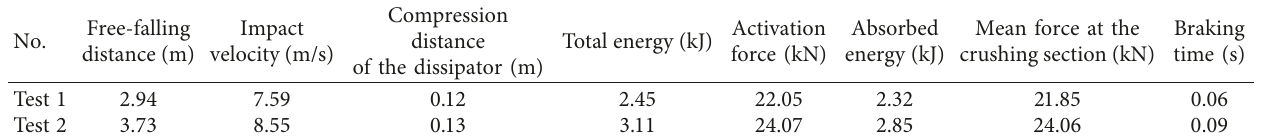
Table 6: Parameters of the symmetric tube-crushing dissipators in the dynamic